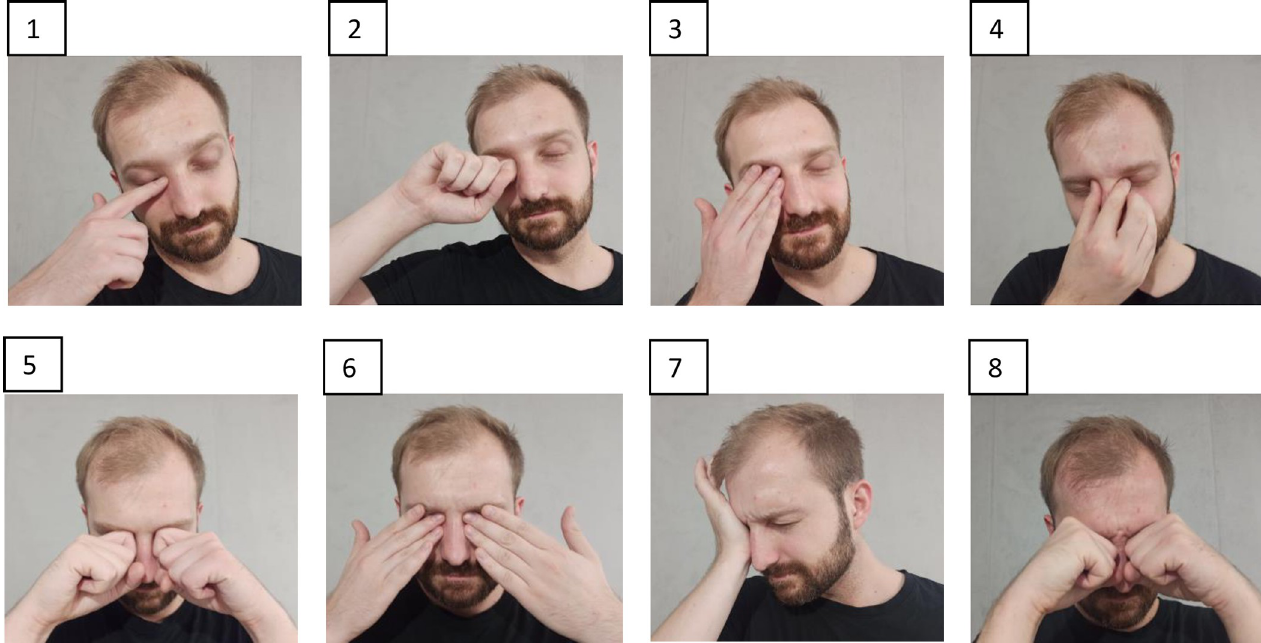
Fig 1. The identification of the eye rubbing manner in the examined individuals. The photographs, numbered from 1 to 8, ranked ascending by their severity/potential harmfulness to the eyeball, included in the Questionnaire for the indication of the eye rubbing manner in the examined individuals. In the Questionnaire, the aspect of eye rubbing manner was verified using the multiple question method (Study Questionnaire, question no. 9: ‘ Please select the photo that most closely resembles the way you rub your eyes’